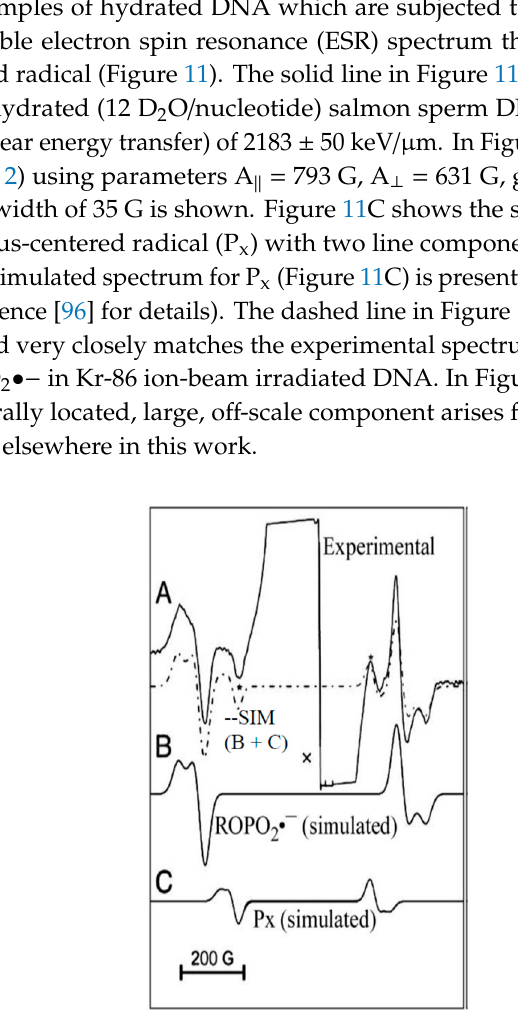
Figure 11. ( A ) Experimental spectra at 77 K of phosphorus-centered radicals in Kr-86 ion beam irradiated (at 77 K), hydrated DNA. The dashed line is the sum of the simulated spectra in B and C. ( B ) Simulated spectrum (for parameters see text) of the main phosphorous-centered radical, ROPO 2 •− . ( C ) Simulated spectrum of unknown phosphorous-centered radical (P x ). (Adapted from reference [96] with permission from Radiation Research, at the 2019 Radiation Research Society).